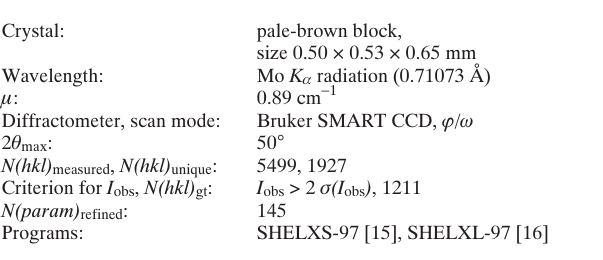
Table 1. Datacollection and